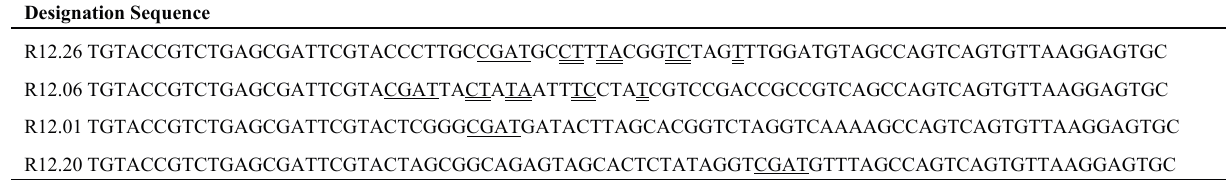
In vitro selection performed for identifying alpha toxin specific ssDNA MRE. Immobilized target (IT) is alpha toxin bound to magnetic beads. Immobilized negative target (INT) are negative targets bound to magnetic beads. BSA is the abbreviation for bovine serum albumin. Times listed are incubation times in